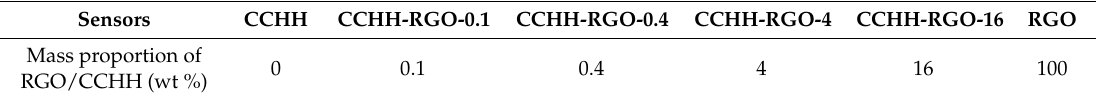
Table 1. Relationship of sensor name and sensing material.